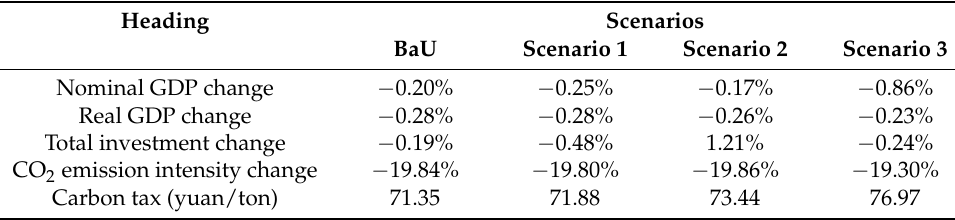
Table 5. Statistics of the economy and carbon